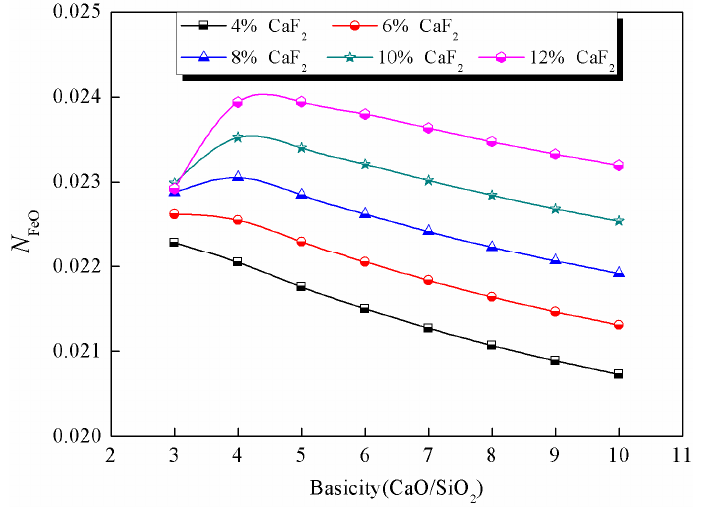
Figure 6. Effect of CaF 2 content on the optimal alkalinity.